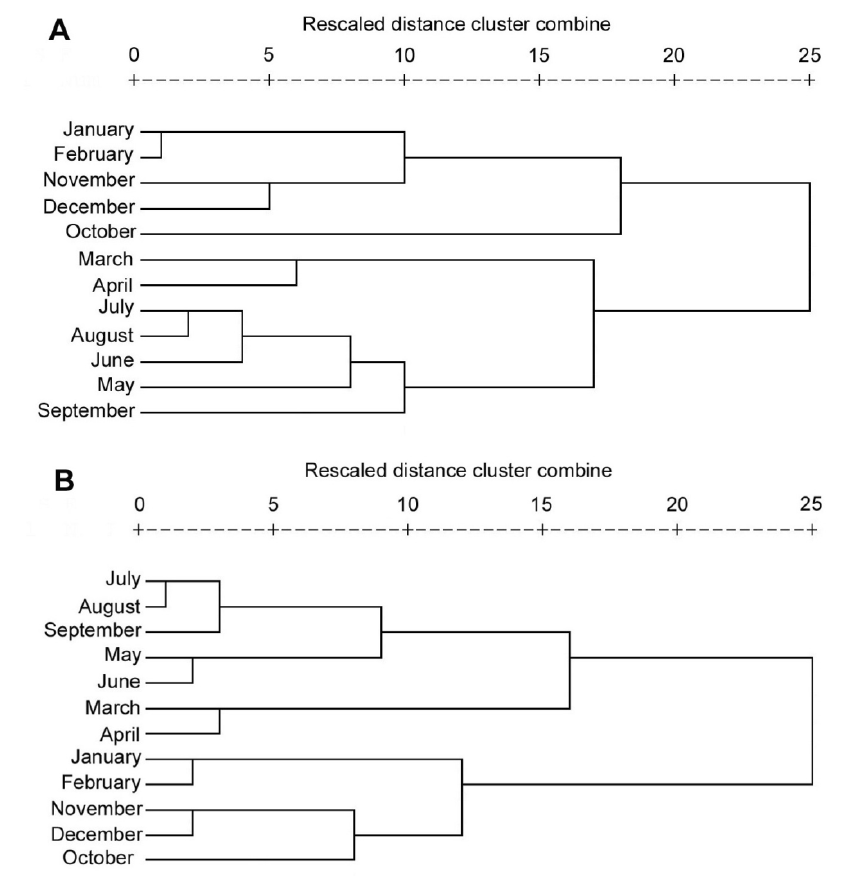
Fig 4 . Dendrogram of utilized pollen type’s similarity. A . Garhbeta. B . Midnapore